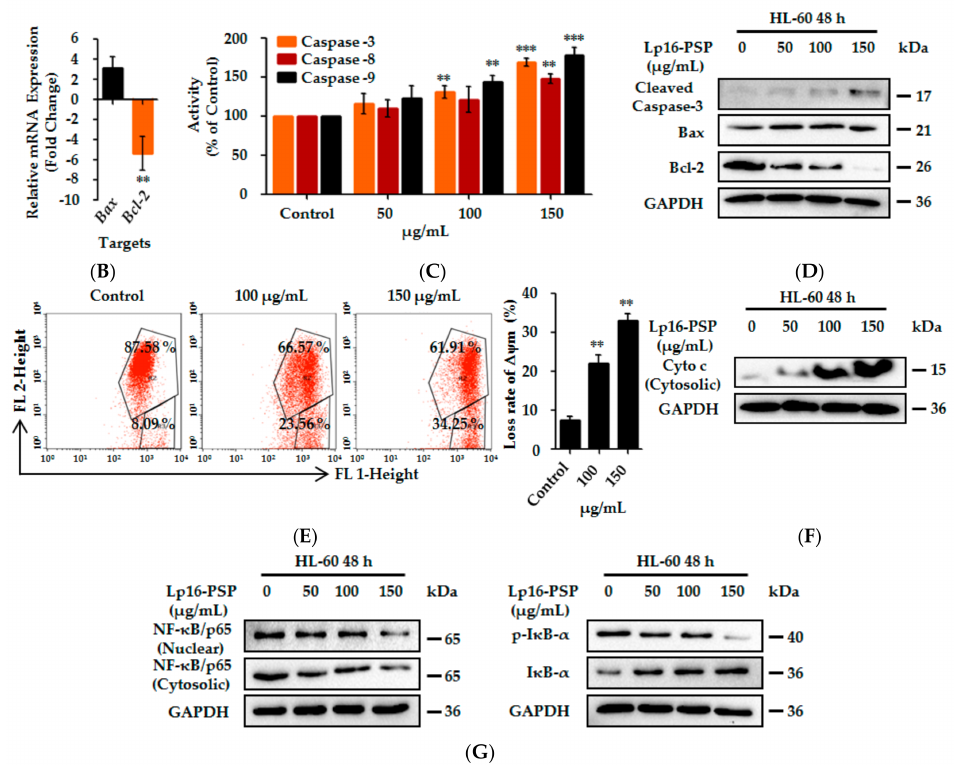
Figure 2. Induction of apoptosis and abrogation of constitutive transcription factor nuclear factor kappa B (NF- κ B) activation by Lp16-PSP in acute promyeloid leukemia (HL-60 cells). ( A ) Apoptosis was analyzed by Annexin-V/PI staining after 48 h treatment of HL-60 cells with indicated concentrations of Lp16-PSP. Left, a histogram of the results from one representative experiment treated with 0, 50, 100 and 150 µ g/mL of Lp16-PSP after 48 h treatment. The lower left (Annexin V − /PI − ) and lower right (Annexin V+/PI − ) quadrants are showing the viable cell population and the cells at the early apoptosis respectively, and the upper-right quadrant (Annexin V+/PI+) is showing the cell population at the late apoptosis. Right, a number of cells in early and late apoptotic phase were calculated. The data are expressed as means ± SD (Standard Deviation) (* p < 0.05, ** p < 0.01) of the three independent experiments; ( B ) The effect of Lp16-PSP on the expression of Bax , a pro-apoptotic, and Bcl-2 , an anti-apoptotic, genes, after 48 h of treatment, as evaluated by qRT-PCR. The mRNAs under investigation from the test were normalized to GAPDH (Glyceraldehyde 3-phosphate dehydrogenase) and plotted as the fold change to the mRNA of control untreated cells, defined as 1. The data expressed here are mean ± SD of the three individual experiments (** p < 0.01; ( C ) The colorimetric analysis of caspase-3, -8, and -9 after treatment with an indicated concentration of Lp16-PSP for 48 h. The data reported here are the mean ± SD of three independent experiments each performed in triplicate (** p < 0.01, *** p < 0.001); ( D ) Western blot analysis of the cleavage of caspase-3, Bax, and Bcl-2 after treatment with different concentrations (0, 50, 100 and 150 µ g/mL) of Lp16-PSP for 48 h, using GAPDH as an internal control. Western blots are representative of the three independent experiments; ( E ) The loss of mitochondrial membrane potential in HL-60 cells after treatment with indicated concentrations of Lp16-PSP for 48 h. Left, results from one representative experiment of HL-60 cells treated with indicated concentrations of Lp16-PSP. Right, the loss rate of mitochondrial membrane potential as compared with the control. The data reported here are mean ± SD (** p < 0.01) of three separate experiments. ( F ) The release of cytochrome c detected by western blotting after treatment with indicated concentrations of Lp16-PSP for 48 h, using GAPDH as an internal control; ( G ) Western blot analysis of the translocation inhibition of NF- κ B into the nucleus after treatment with indicated concentrations of Lp16-PSP for 48 h, using GAPDH as an internal control. Western blots are representative of three independent